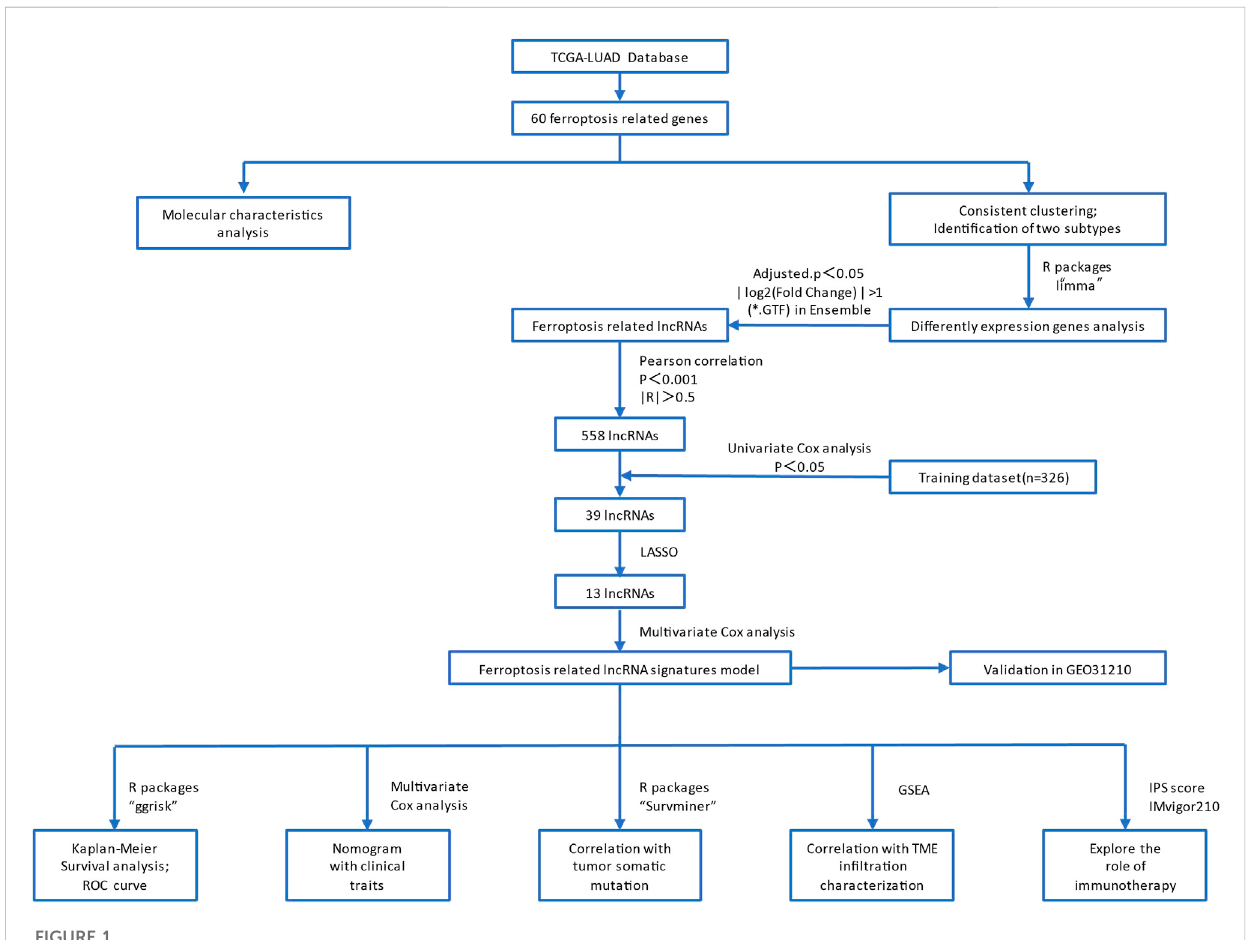
FIGURE 1 The fl ow chart of this